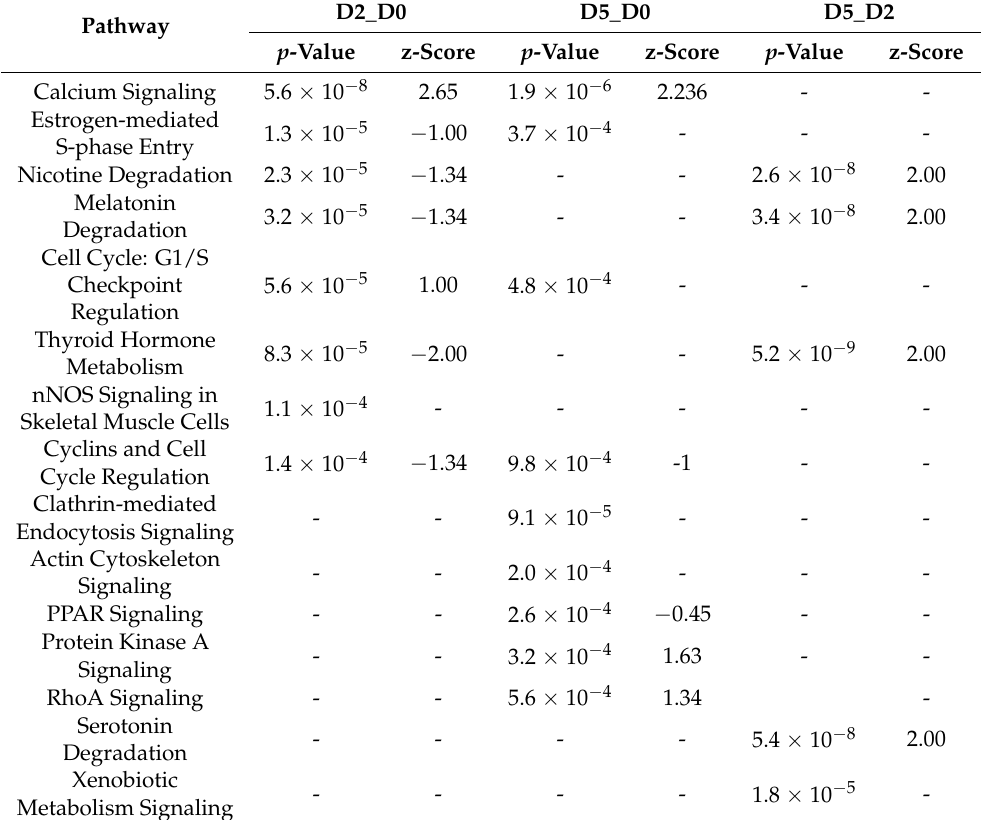
Table 1. Top functional enrichments among differentially expressed mRNAs that are predicted targets of miRNAs. Only the most significantly enriched term among closely related terms was